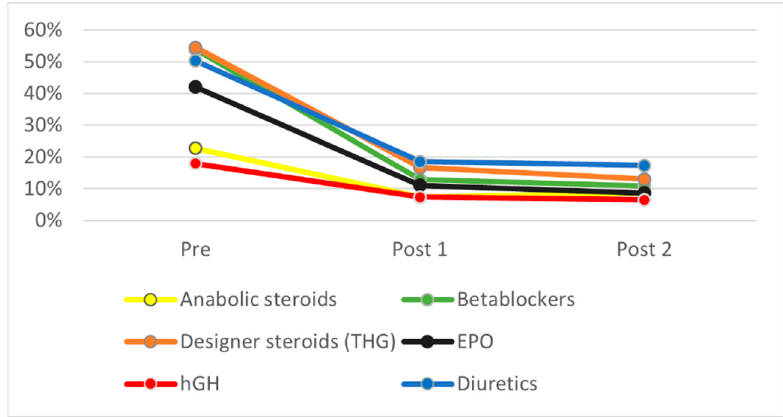
Figure 1. General ignorance about PES use on performance.